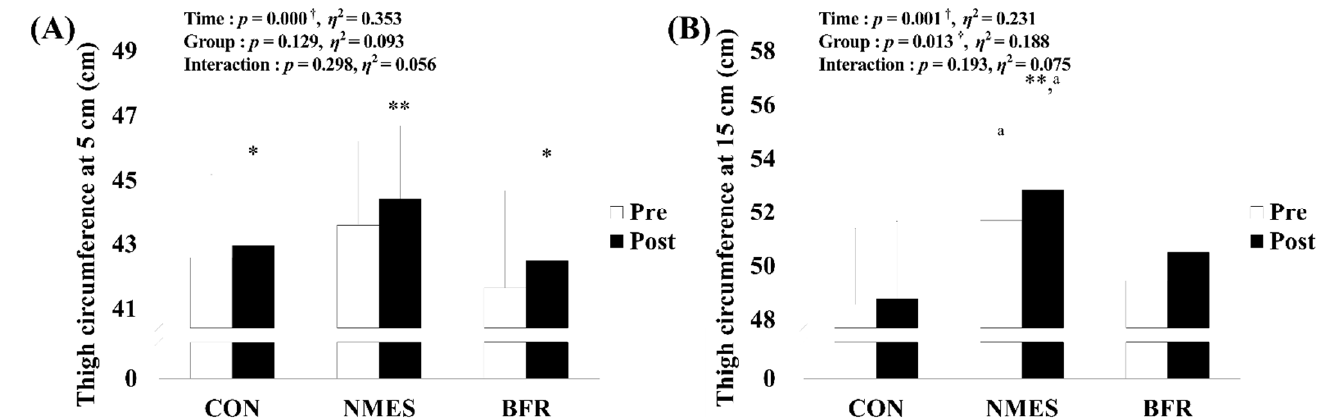
Figure 4. Changes in thigh circumference at 5 cm and 15 cm via rehabilitation interventions in each group. ( A ) Change in thigh circumference at 5 cm. ( B ) Change in thigh circumference at 15 cm. CON, control group; NMES, neuromuscular electrical stimulation group; BFR, blood flow restriction group. Significant interaction or main effect: † p < 0.05; Significant difference in each group via rehabilitation intervention: * p < 0.05, ** p < 0.01; Significant difference between groups each time: a p < 0.05.